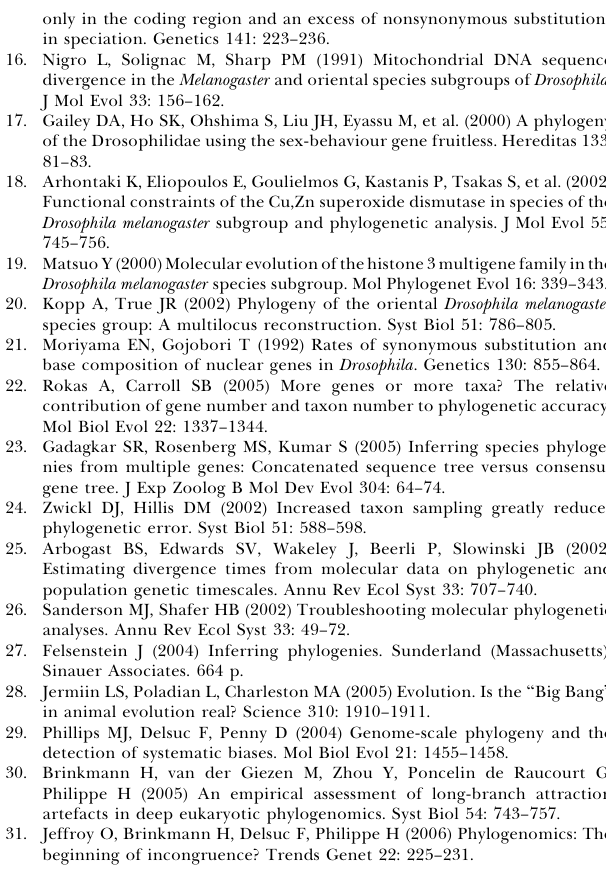
Figure S10. Clustering of Informative Sites with RY Coding